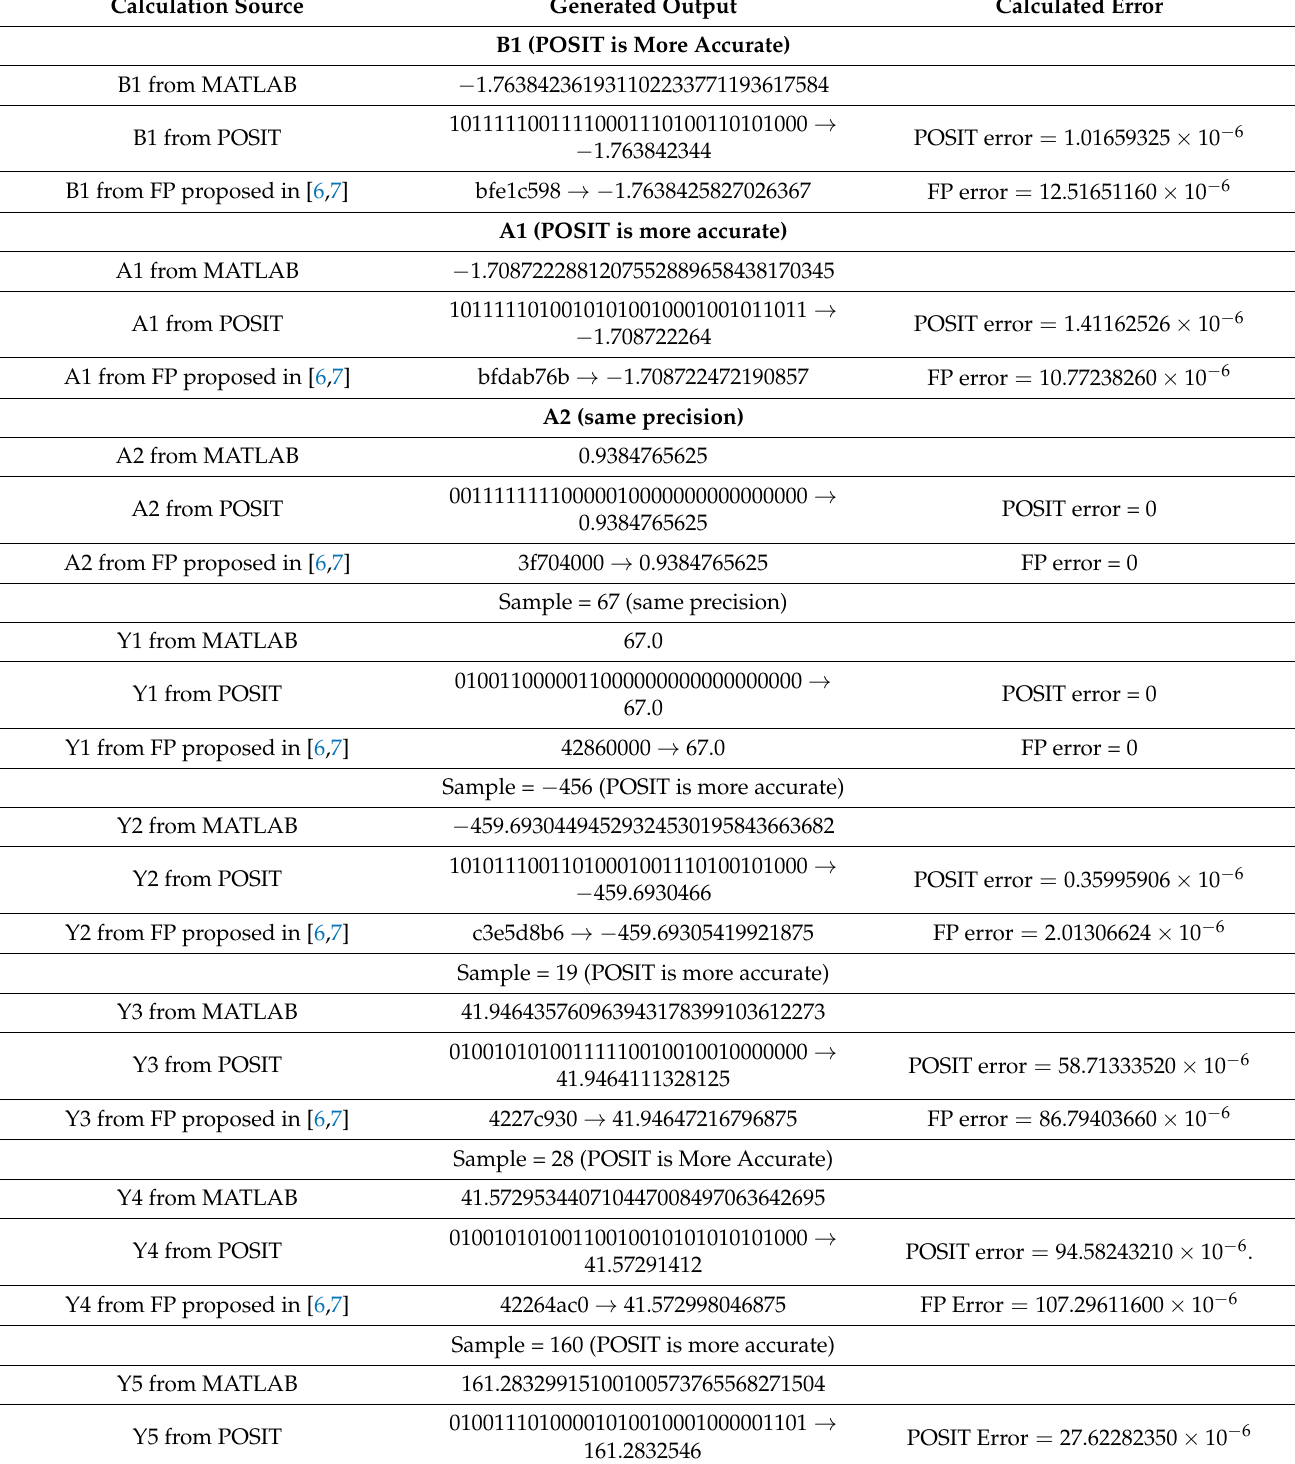
Table 7. Comparison of accuracy between 32-bit POSIT and 32-bit floating